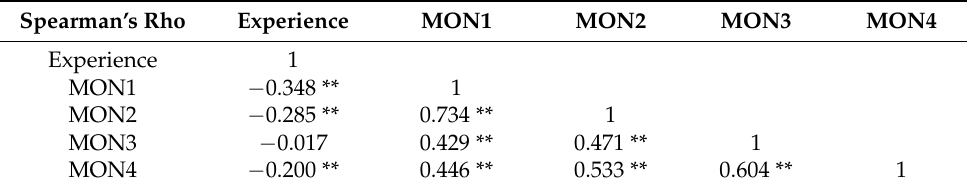
Table 16. Correlation coefficient between the H&S considerations in contract administration and monitoring.